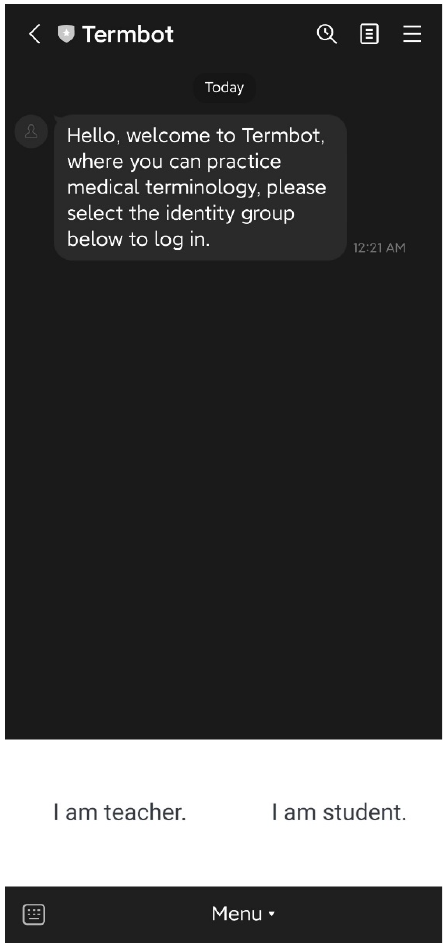
Figure 3. The initial screen of Termbot.